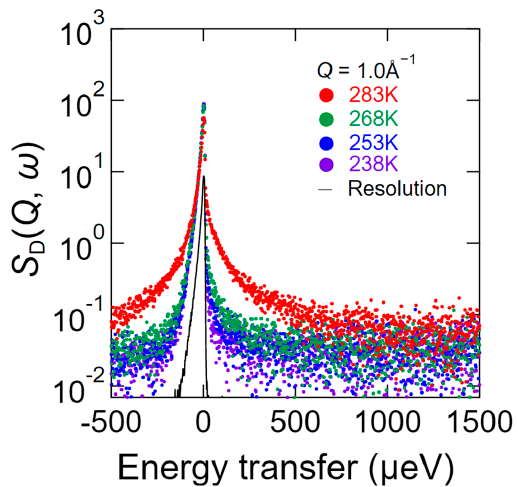
Figure 5. QENS profiles of S D ( Q , ω ) at Q = 1.0 Å − 1 in the energy range of − 500 to 1500 µeV with a resolution of 12 µeV at 238 K (purple), 253 K (blue), 268 K (green), and 283 K (red). S D ( Q , ω ) is the scattering intensity of the chitosan hydrated with D 2 O, which is interpreted in terms of single hy- drogen atom dynamics. The black curve represents the resolution profile of vanadium obtained by QENS.